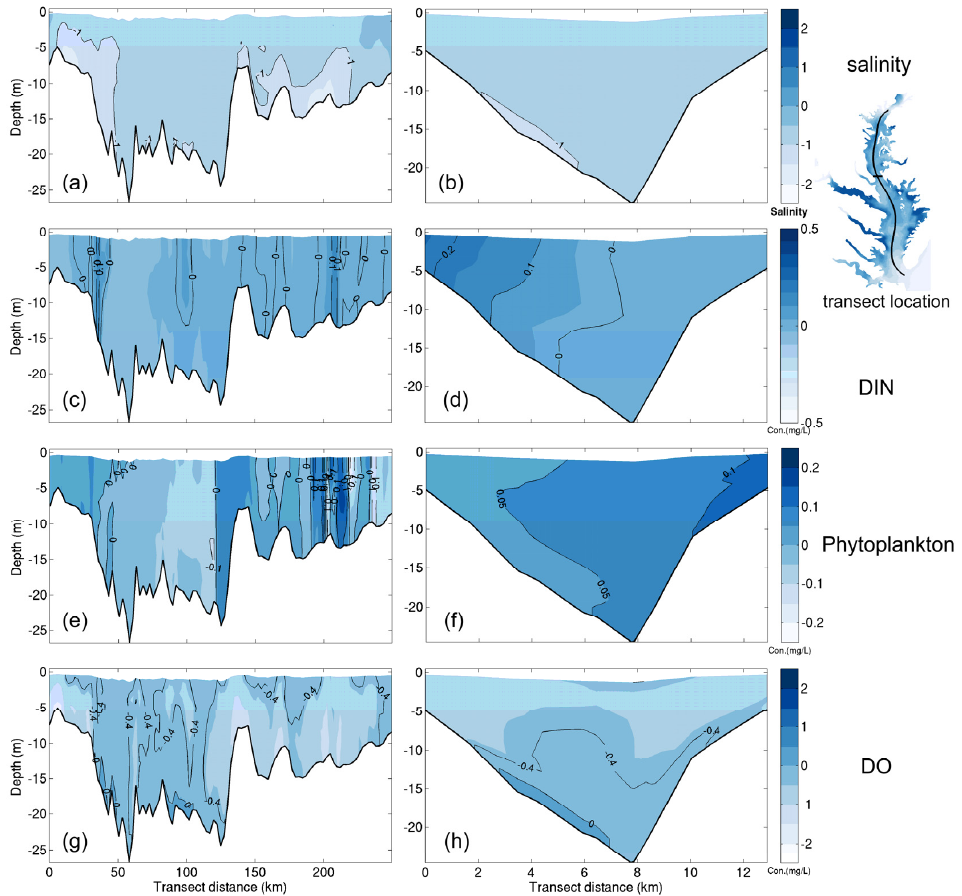
Figure 7. Difference in simulated ( a ) along-bay and ( b ) across-bay salinity in May; ( c ) along-bay and ( d ) across-bay dissolved inorganic nitrogen in May; ( e ) along-bay and ( f ) across-bay phytoplankton biomass in May and ( g ) along-bay and ( h ) across-bay dissolved oxygen in July between the 11-sigma-level and 21-sigma-level models. The along-bay and across-bay transects are shown on the rightmost panel.